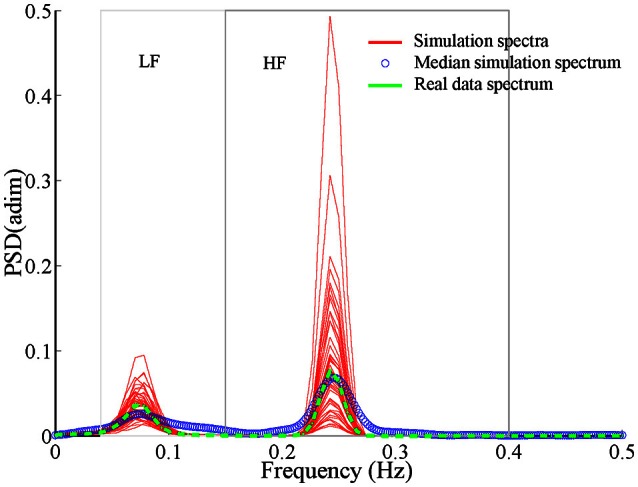
Spectra derived from 50 stochastic realizations of simulated modulating signals during supine conditions (data simulates subject conditions from Fantasia database) applying ARMA technique fixing LF and HF content (red lines). Average spectrum is shown in circles (blue) and spectrum belonging to real data in dashed line (green).